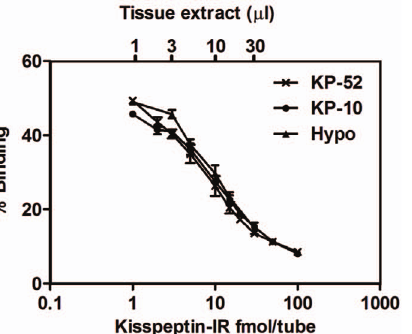
Figure 1. HPLC profile of kisspeptin-immunoreactivity from hypothalamic extracts. Solid lines- Kisspeptin concentration; broken lines-% acetonitrile (ACN). Q KP-52 represents the elution position of Kisspeptin-52 standard. The recovery of Kisspeptin-IR in the tissue extract from each column run was above 80% (means S.E.M.; n=4).